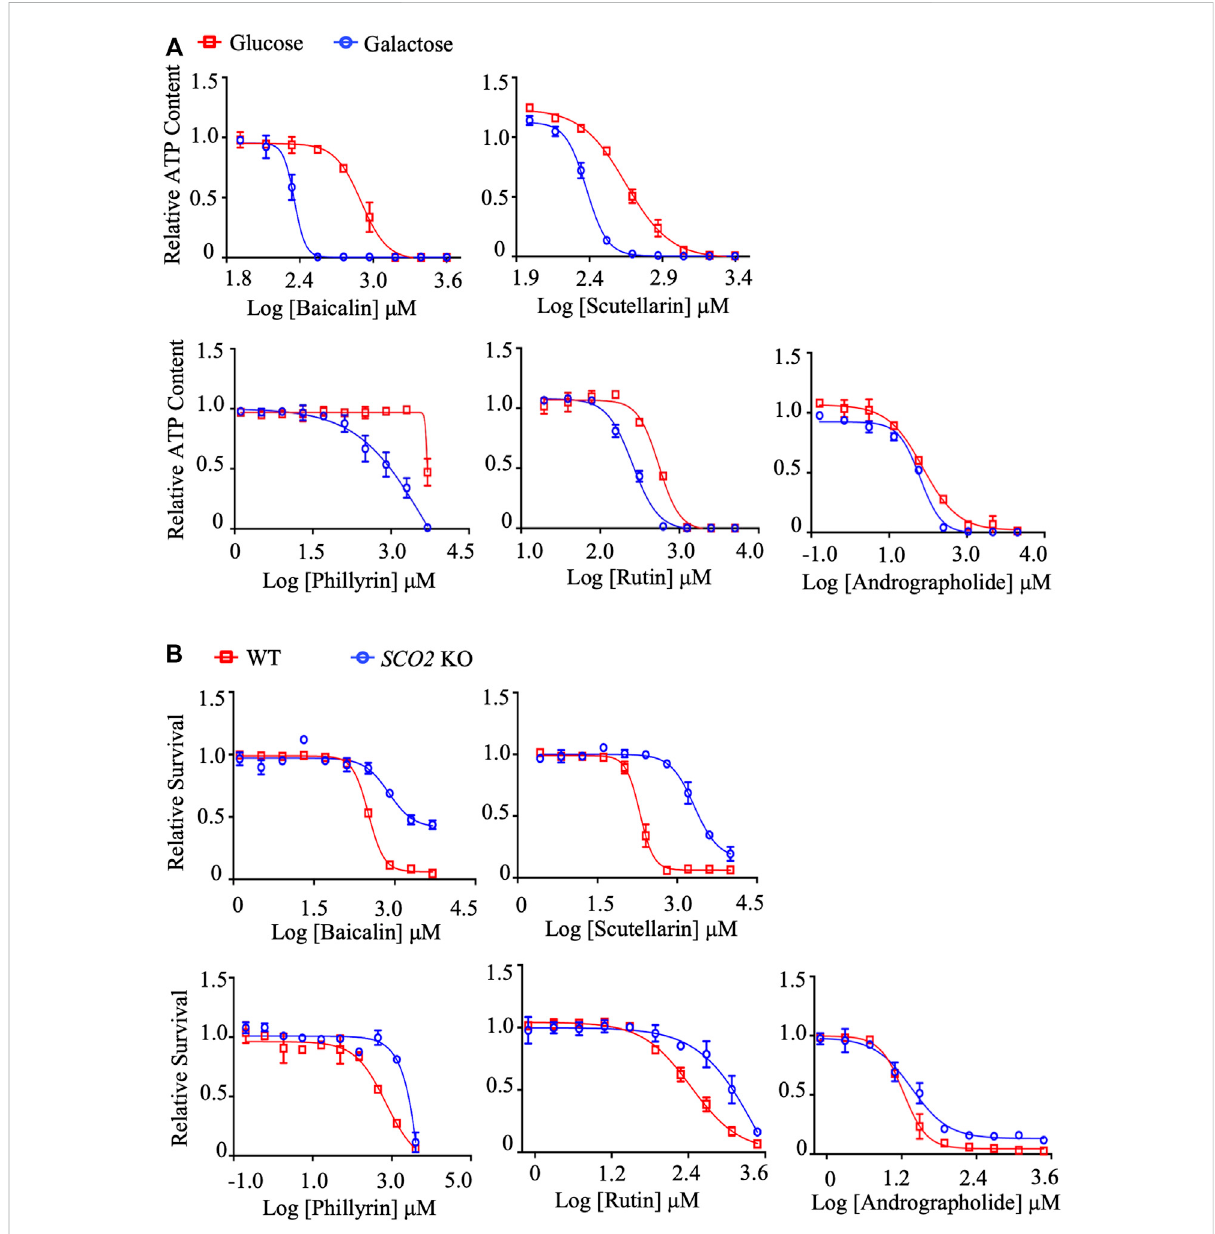
FIGURE 4 In vitro validation of mitochondrial toxicity of identi fi ed TCM ingredients. (A) Concentration responses for high-glucose-grown (25 mM) and galactose-grown (10 mM) (blue) HepG2 cells treated with baicalin, scutellarin, rutin, phillyrin, and andrographolide. After 48 h of treatment, the ATP content was assessed. (B) HCT-116 (WT; SCO2 KO) cells were treated with indicated concentrations of baicalin, scutellarin, rutin, phillyrin, and andrographolide for 72 h. Cell viability was assessed by the SRB assay. Average values are from three independent experiments performed in duplicate ( n = 3). Data are shown as mean ±